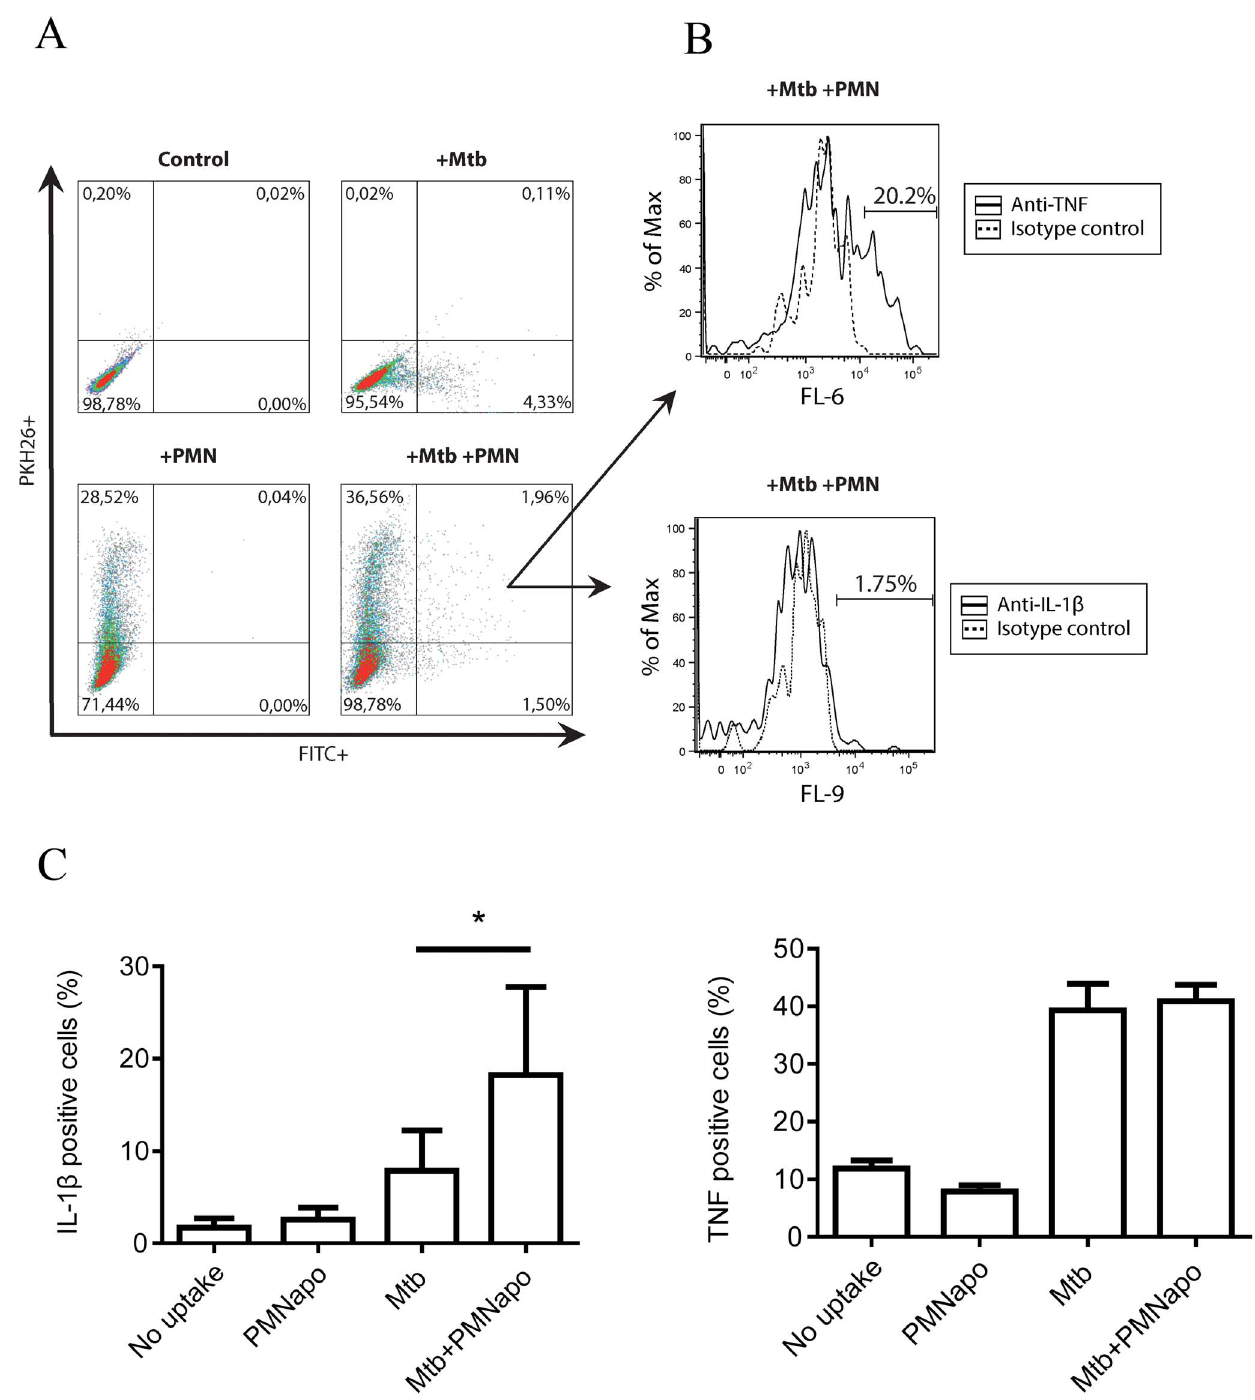
Figure 5. Uptake of apoptotic neutrophils increases the number of IL-1 b producing cells in the infected cell population. hMDMs were stimulated with FITC labeled c -irr Mtb at a ratio of 5:1 (Mtb), with subsequent stimulation with PKH26-labeled PMNapo at a ratio of 2:1 (Mtb + PMNapo). The hMDMs were stained for intracellular IL-1 b (Pacific Blue) and TNF a (Alexa Fluor 647) and analyzed by flow cytometry. (A) The figure shows shows the percentage of hMDMs (based on forward/side scatter) positive for Mtb (FITC/FL-1), PMNapo (PKH26/FL-2) or both. (B) The histograms show the percentage of TNF a (Alexa 647/FL-6) or IL-1 b (Pacific Blue/FL-9) positive cells in the population of hMDMs which have phagocytosed both Mtb and PMNapo. (C) The figure shows the number of IL-1 b or TNF a producing cells (%) in the following subpopulations; FITC 2 / PKH26 2 (no uptake), FITC 2 /PKH26 + (PMNapo uptake), FITC + /PKH26 2 (Mtb uptake) and FITC + /PKH26 + (Mtb + PMNapo). (n=5). Differences between groups are shown as * (p , 0.05).